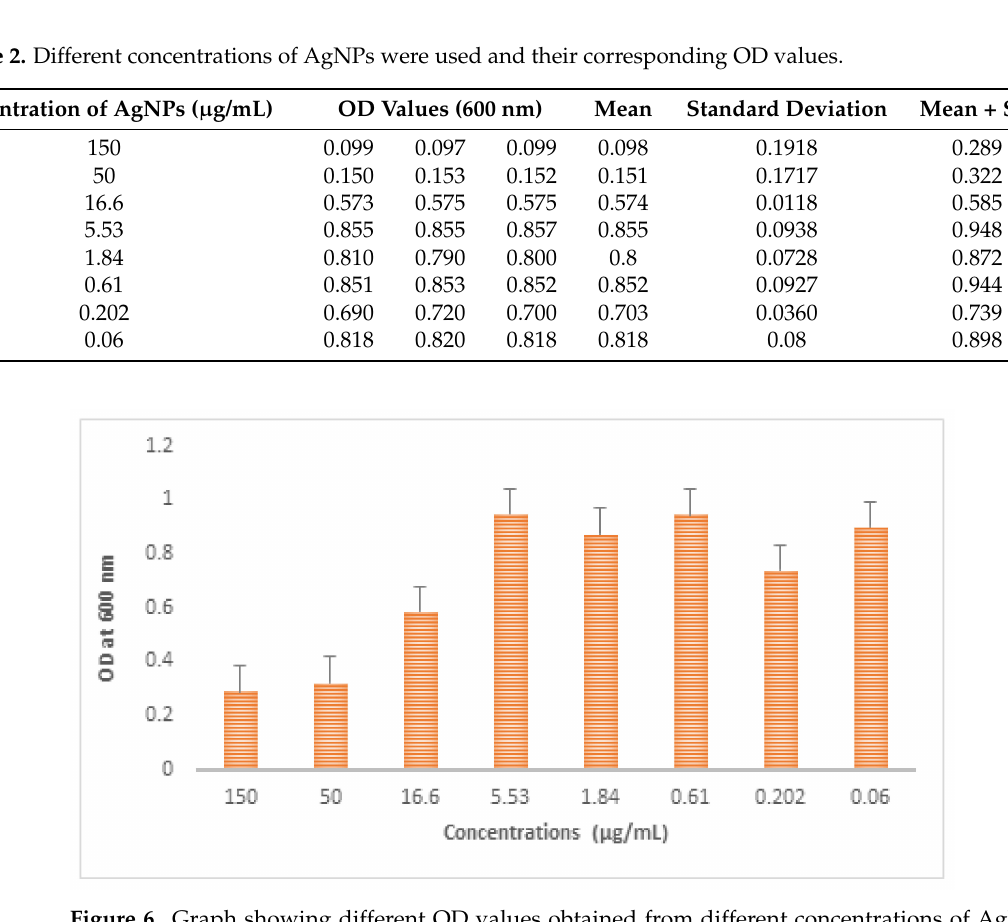
Figure 6. Graph showing different OD values obtained from different concentrations of AgNPs against Escherichia